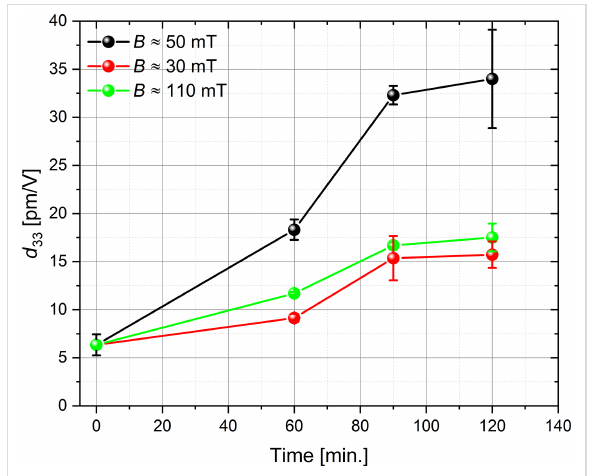
Figure 4: Value of d 33 of the nanocomposites with 5 wt % of CoFe 2 O 4 as a function of the application time of the DC magnetic field.